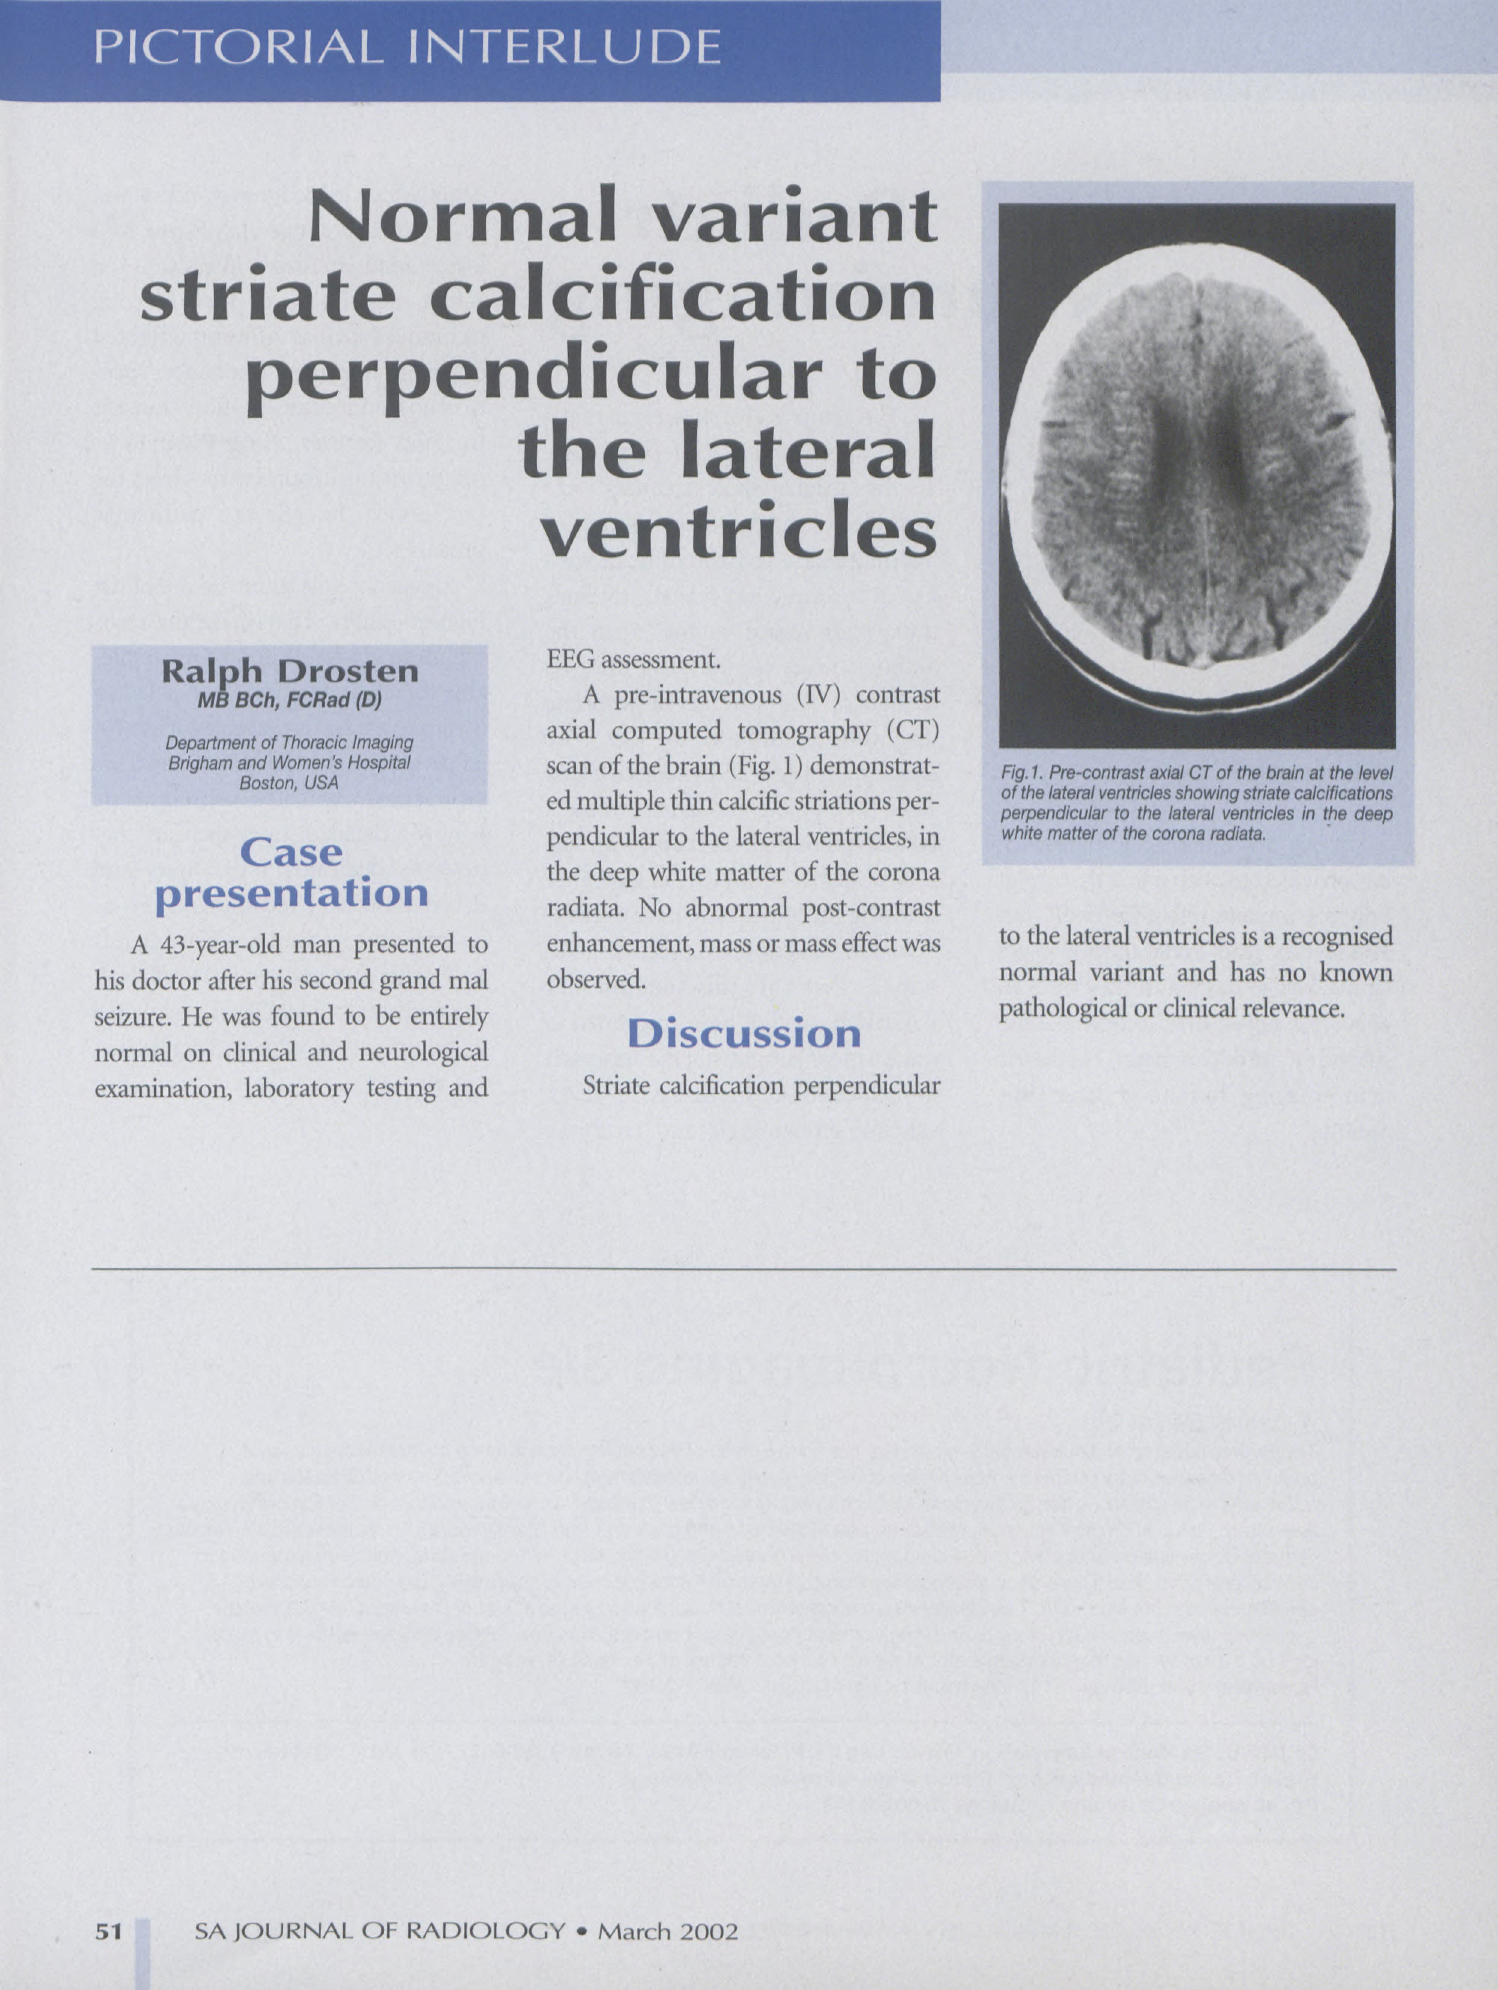
to the lateral ventricles is a recognised normal variant and has no known pathological or clinical